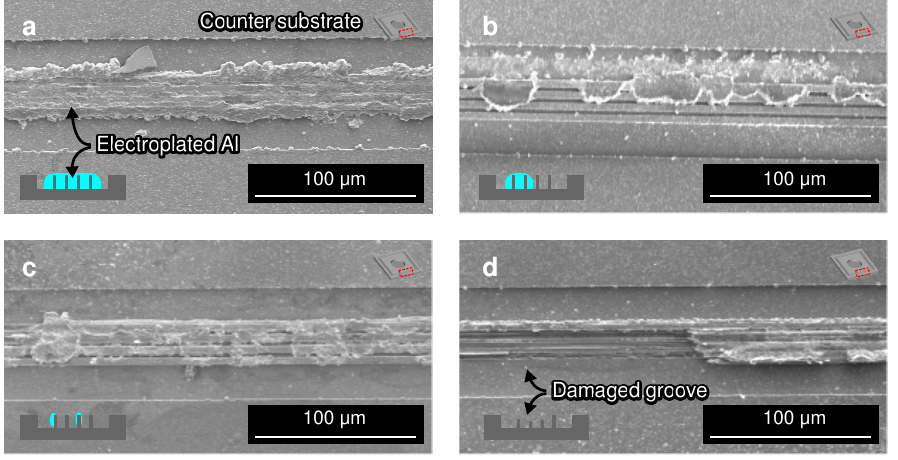
Figure 11. Scanning electron micrographs of the fracture surface after shear test of the bonded packages at ( a ) 450 ◦ C, ( b ) 350 ◦ C, and ( c , d ) 250 ◦ C bonding